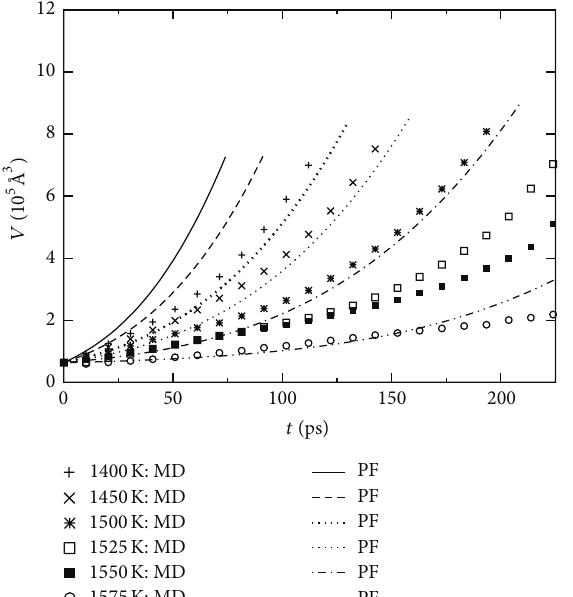
Figure 3: Evolution of the crystalline cluster volume at different temperatures. MD results are the average over 8 independent simu- lation runs.